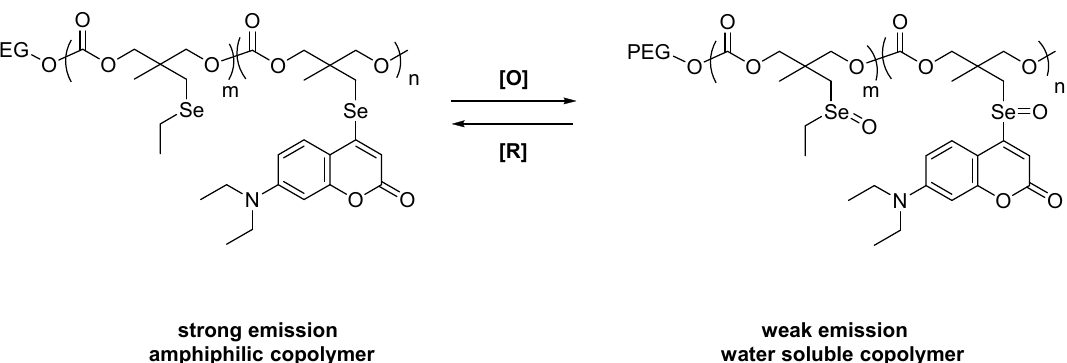
Figure 7. The chemical structure of the amphiphilic copolymer and the water–soluble copolymer studied in the context of nucleophilic attack and fluorescence changes by Yu et al.